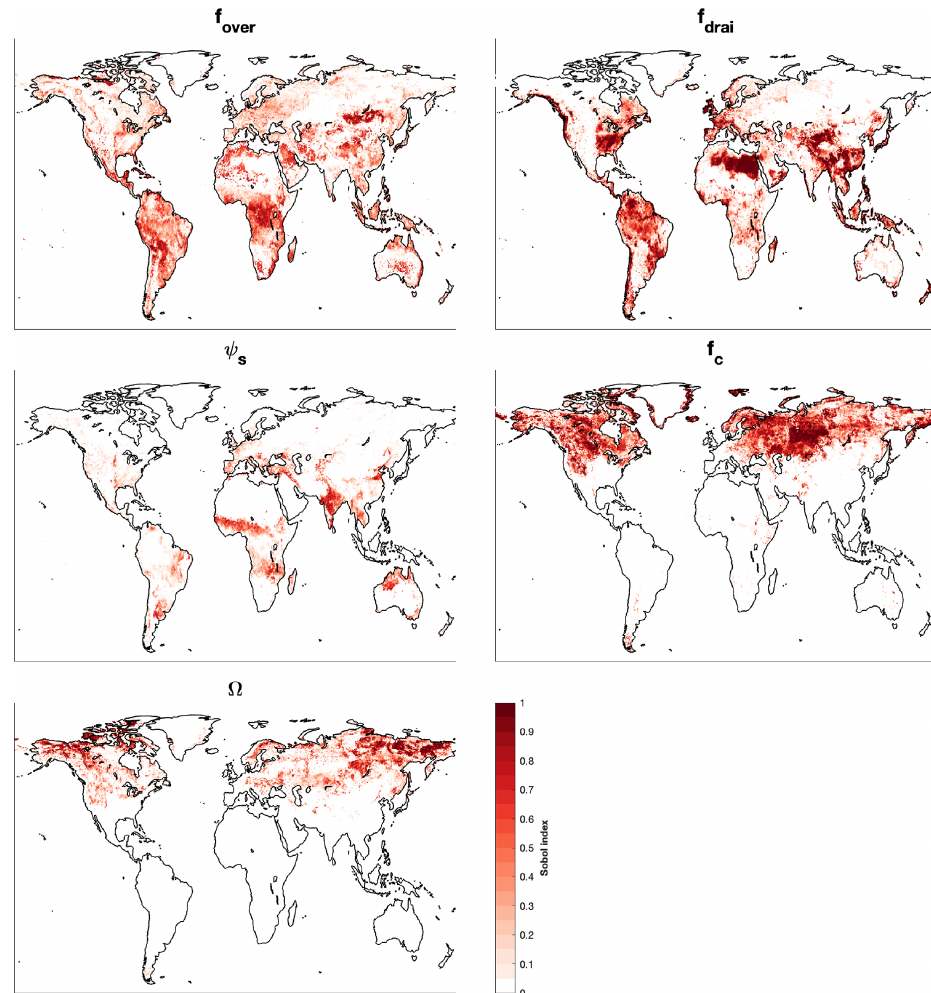
Figure 4. Spatial distribution of the main Sobol’ index for the sensitivity parameters.